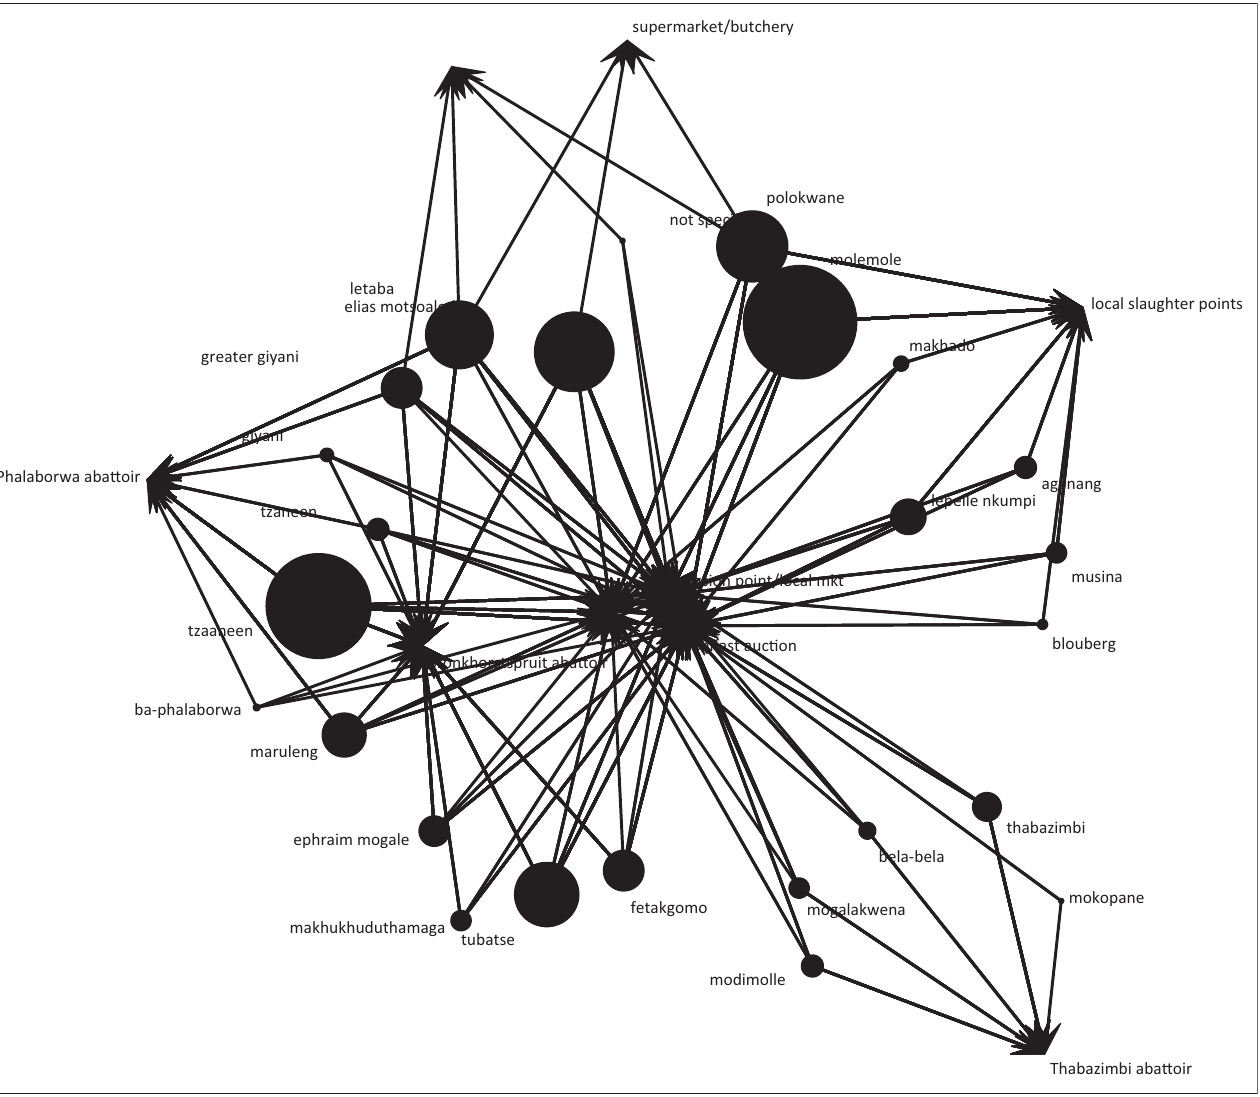
FIGURE 6: Multidirectional network map of out-degree connectedness of locations of emerging small-scale pig farmers in Limpopo,